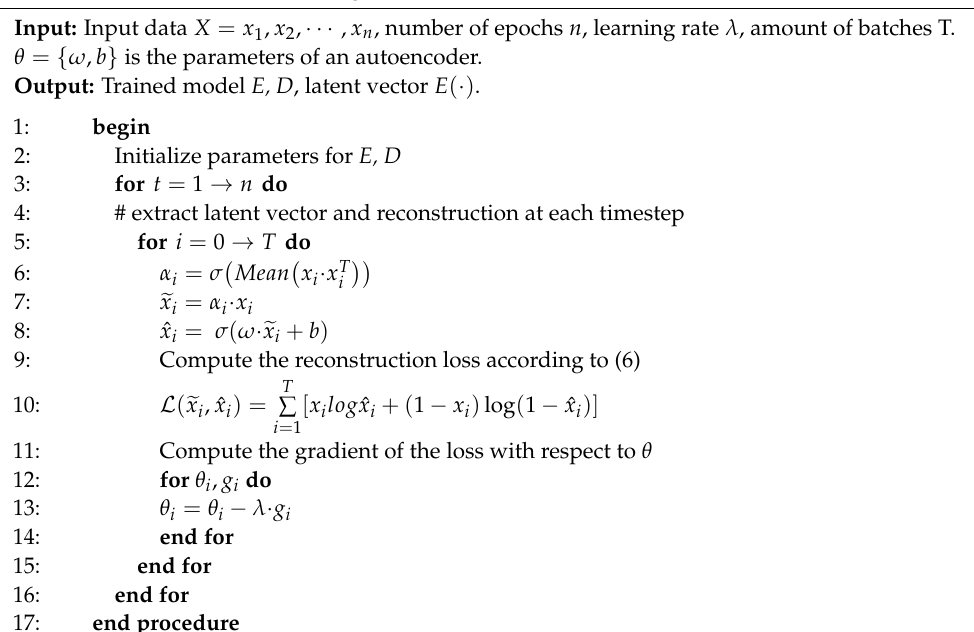
Algorithm 1 Autoencoder Training